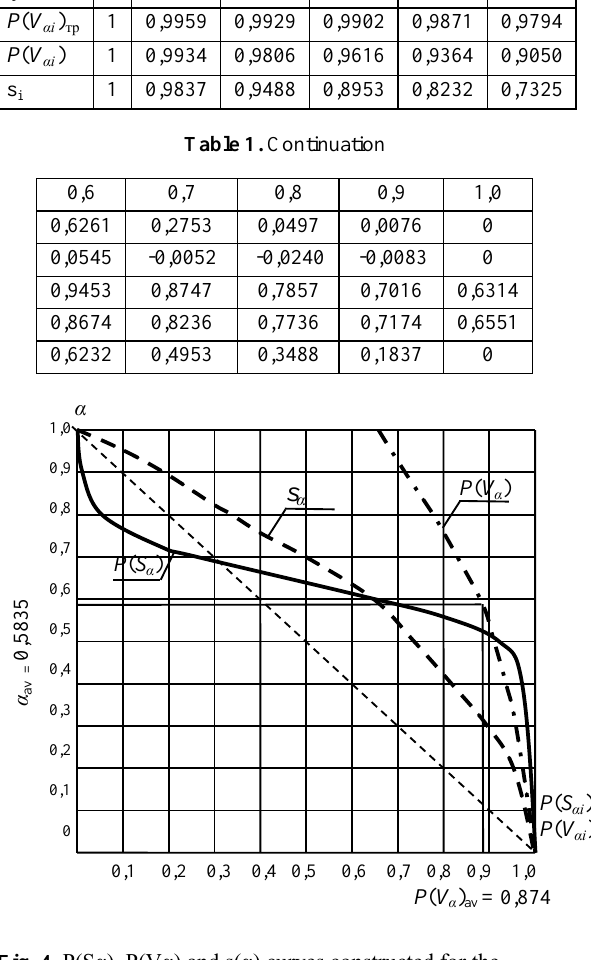
Fig. 4. P(Sα), P(Vα) and s(α) curves constructed for the profilogram and diagram depicted on fig. 3 (first section of the profilogram on fig.